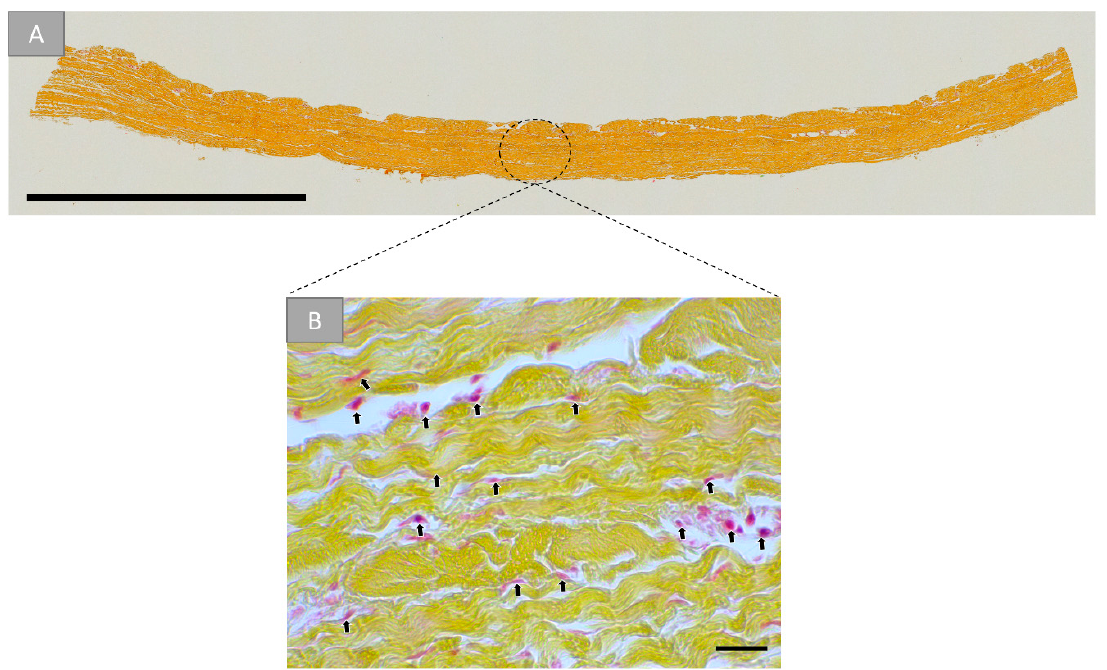
Figure 2. ( A ) Cross-sectional overview and detail microscopic image ( B ) of the purified bovine pericardial tissue. Arrows: remaining donor cells (Movat pentachrome stainings, ( A ) “total scan, scalebar = 2 mm, ( B ) 40× magnifications, scale bars = 20 µm).